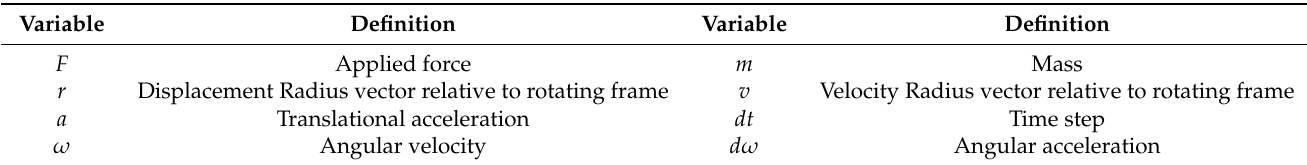
Table 1. The 6 DoF Motion Equation Variable